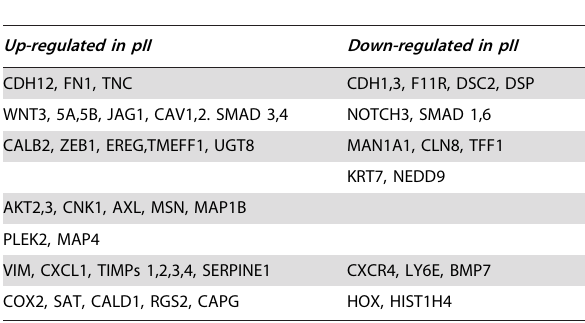
Table 3. Genes associated with invasion and metastasis.